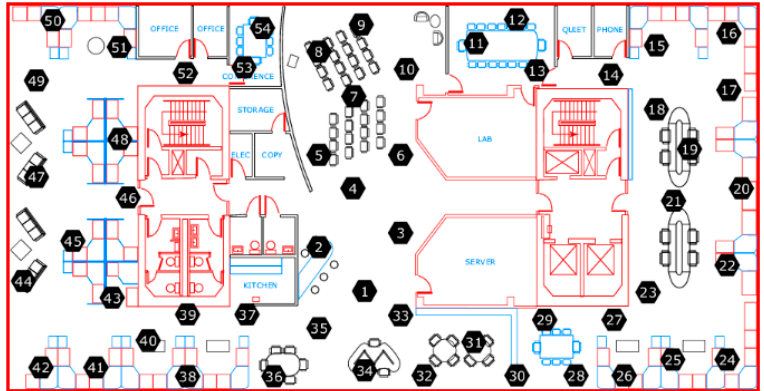
Figure 14. Location distribution of the sensor nodes.